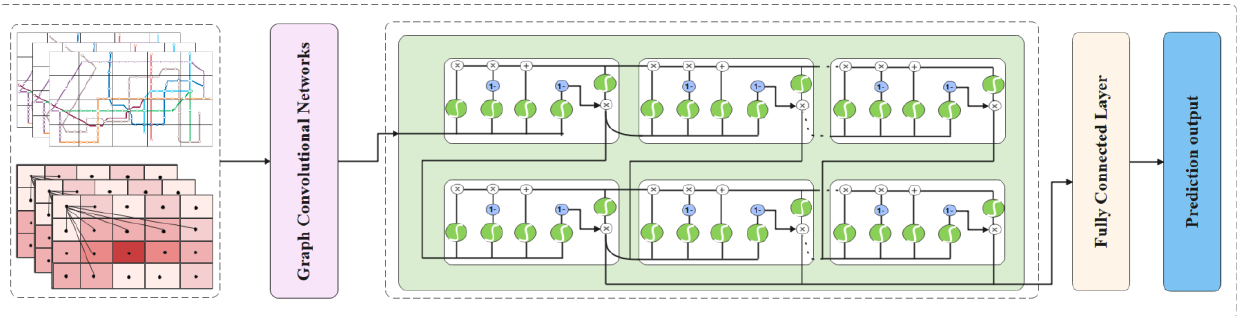
Figure 1. DSGCN model architecture diagram.